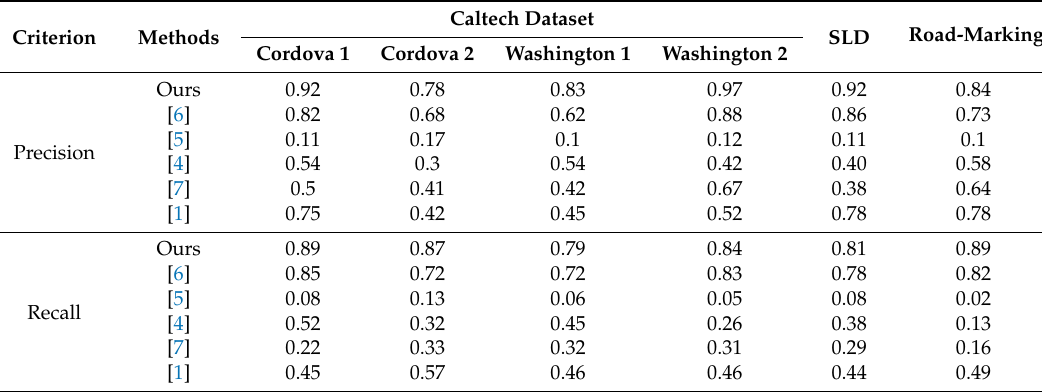
Table 7. Comparative experimental results by our method and previous methods.